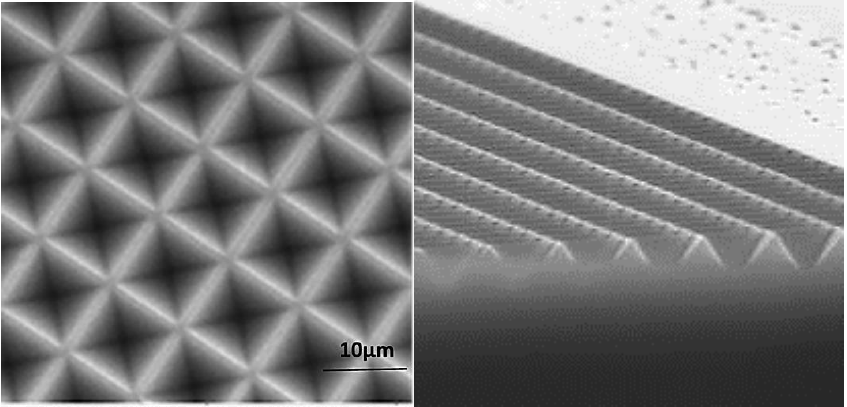
Figure 5. Optical microscope images of micro-texturized surface of photovoltaic cells (pyramids).